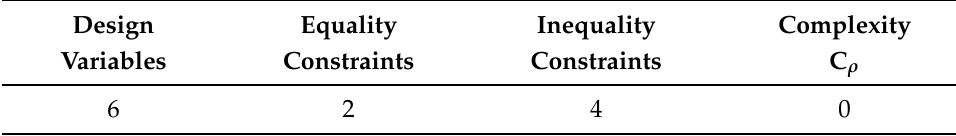
Table 2. Computational characteristics of the case